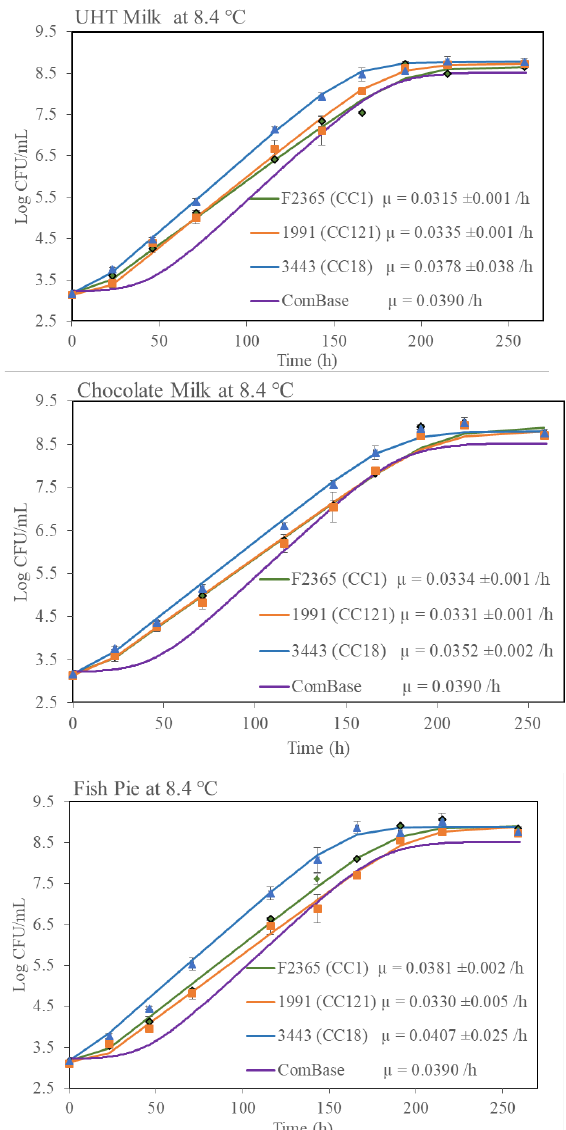
Figure 6. Growth kinetics of three L. monocytogenes isolates in three different food matrices at 8.4 °C. Growth rates (µ) shown were calculated by using DMFit excel version 3.5 provided by ComBase. Error bar represented standard deviation of biological repeats at respective time point.